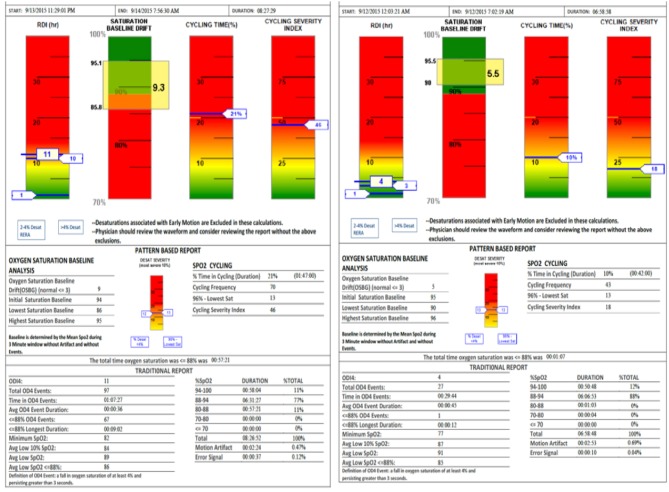
SatScreen report (Left RDI 13—Prone Sleeper, Right RDI 4—Left Side Sleeper) shows the difference between two body positions with the appliance adjustment unchanged.